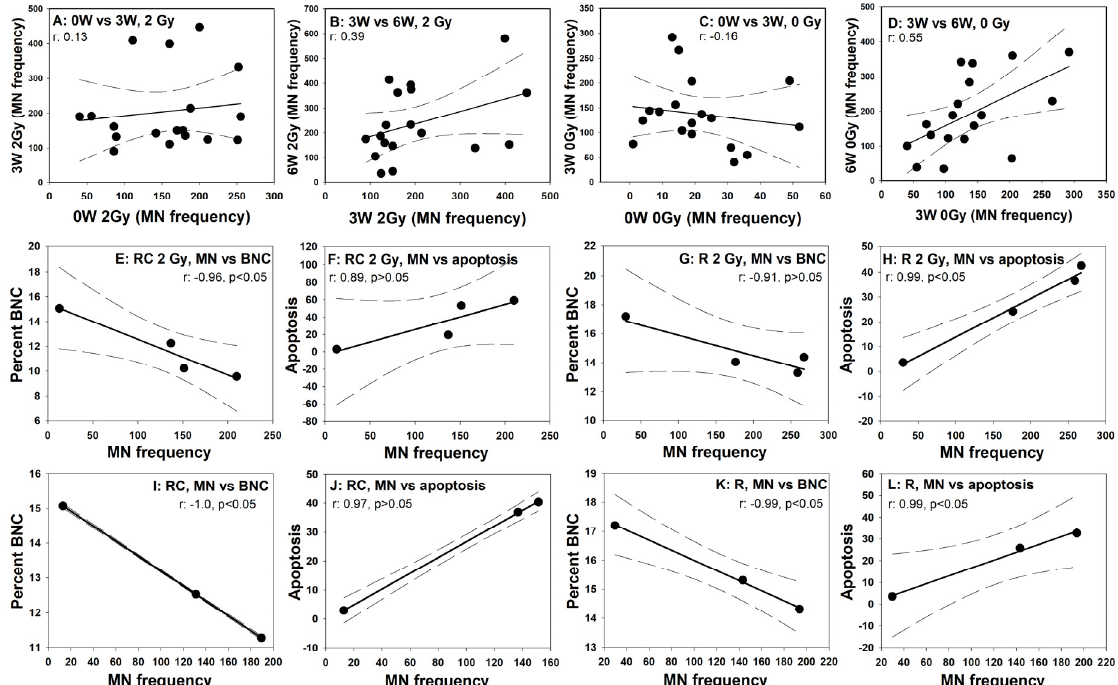
Figure 6. Correlations. Panels ( A – D ): correlations between individual micronucleus frequencies observed in all 18 donors at different blood collection time points. Panels A and B: micronuclei induced by therapy + 2 Gy. Panels ( C ) and ( D ): micronuclei induced by therapy alone. Panels ( E – L ): correlations between the mean frequencies of MN, percent BNC and percent apoptosis. Panels ( E – H ): results after 2 Gy ex vivo irradiation (RC patients: ( E , F ), R patients ( G , H )), panels ( I , L ): results after therapy alone (RC patients: ( E , F , I , J ), R patients ( K , L )). W: week of treatment. Dashed lines symbolise 95% confidence intervals.